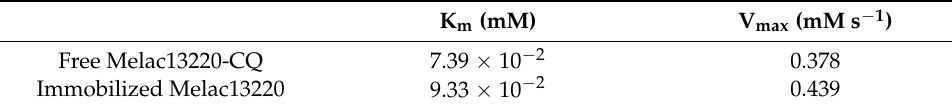
Table 4. The kinetic parameters of free and immobilized Melac13220.